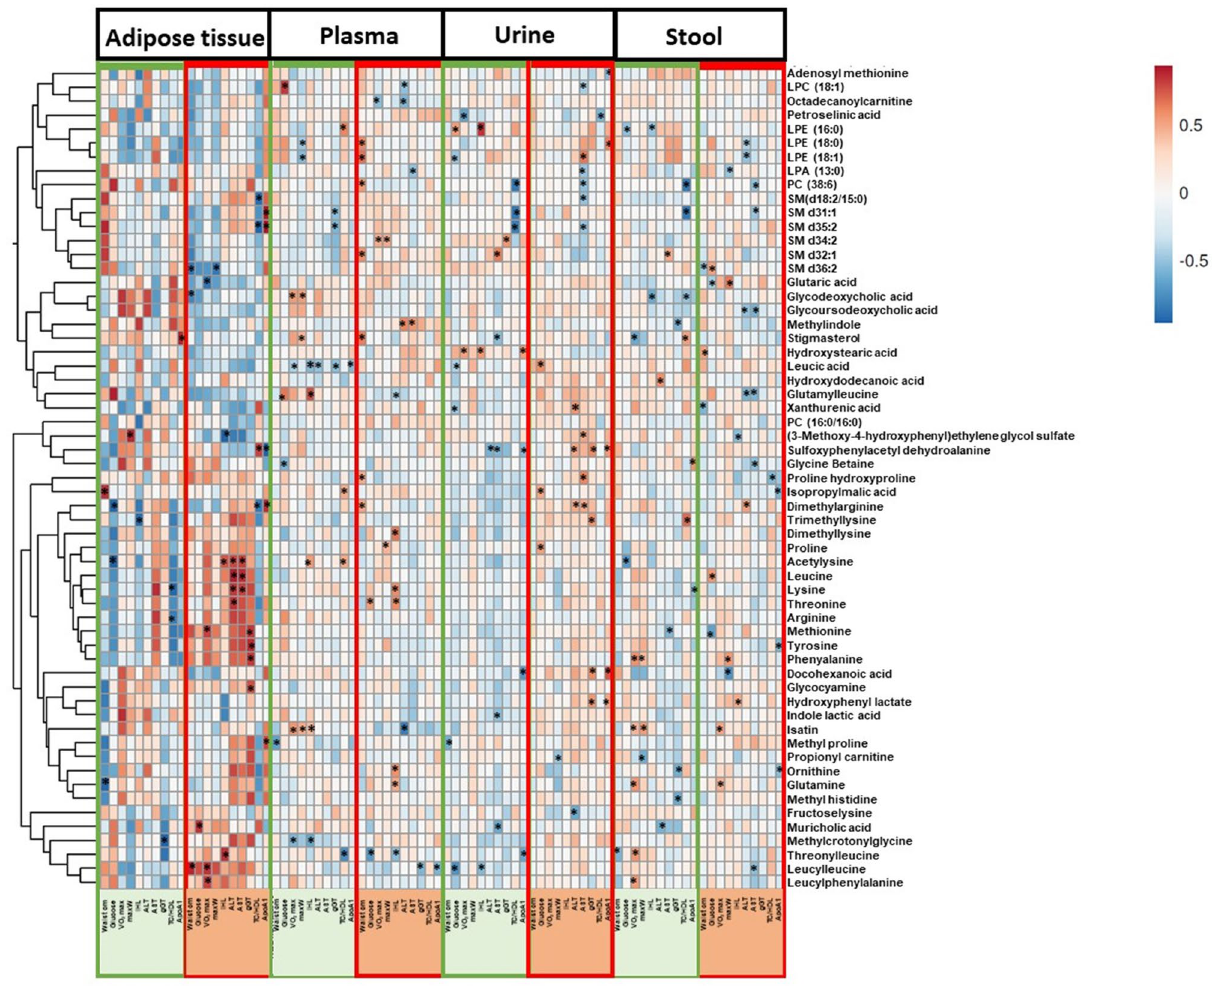
Figure 3. Heatmap representing the significant Spearman’s correlations (adjusted for age, gender, BMI, and T2D) between the clinical parameters (column-wise) and the top significantly different metabolites identified in all sample matrices combined (row-wise) using delta change from baseline to post intervention. The color of the cells indicates the strength of the relationship (r s ). The cells marked with asterisks (*) demonstrate significant correlations (p < 0.05). Green sidebars indicate the control group, and red sidebars represent the exercise intervention group. Waist cm waist circumference, IHL intrahepatic lipid content, ALT alanine aminotransferase, AST aspartate transaminase, gGT gamma-glutamyl transferase, VO 2 max the maximum rate of oxygen consumption (cardiorespiratory fitness), maxW maximum workload achieved, TC total cholesterol, HDL high-density lipoprotein glucose concentration, VO 2 max, and waist circumference were mostly positively correlated with amino acids in AT in the intervention group (Fig. 3). In the intervention group, waist circumference was positively correlated with leucyl-leucine in AT; dimethylarginine, methylproline, and proline hydroxyproline in plasma; and negatively correlated with xanthurenic acid in stool. Plasma glucose concentration was positively correlated with threonine in plasma; proline, leucic acid, and isopropylmalic acid in urine; and leucine in stool. Significant negative cor- relations of trimethyllysine in plasma; and glutaric acid and methionine in stool with waist circumference were also observed. VO 2 max was significantly positively correlated with leucyl-leucine, leucylphenylalanine, and methionine in AT; and glutamine and isatin in stool. Proline in plasma; and glutaric acid and phenylalanine in stool positively correlated with maxW. In AT, while strong positive correlations of most of the amino acids and derivatives were observed with the liver parameters (Fig. 3), only proline, methylproline, sulfoxyphenylacetyl dehydroalanine, and isatin correlated significantly with lipid parameters (Fig. 3 and Supplementary Fig. 3). Lipids and lipid‑derived compounds. Exercise also induced changes in several lipids and their derived compounds, including sphingolipids, bile acids, glycerophospholipids, acylcarnitines, and sterols across the four different sample matrices. Moreover, the pathway analysis also revealed marked differences in lipid metabolism pathways in plasma (Supplementary Fig. 2). As visualized in the volcano plot (Fig. 2), in plasma, six sphingo- myelins (SMs) [SM d31:1, SM d32:1, SM d34:2, SM d35:2, SM d36:2, SM d(18:2/15:0)] and a ceramide (Cer